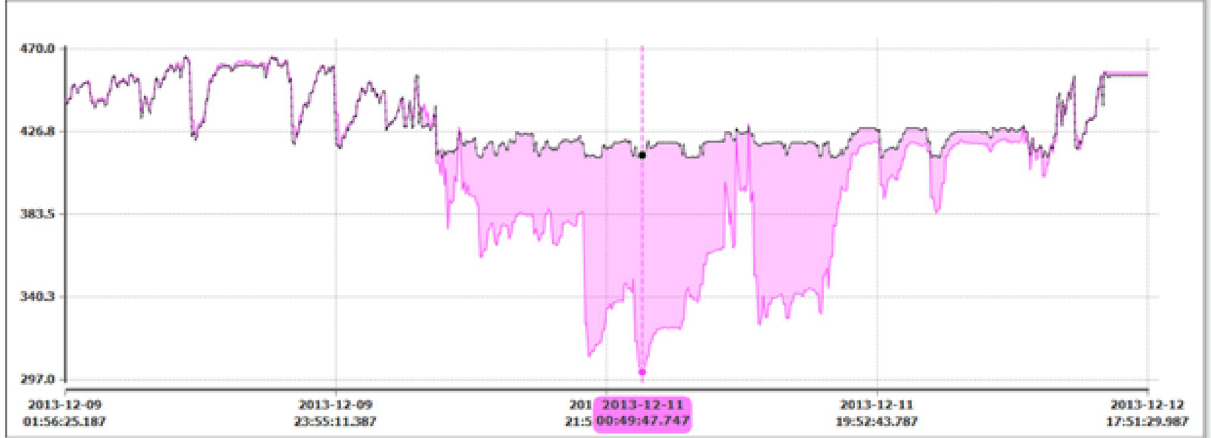
Figure 15. Case 1. Drop in steam temperature. Comparison of the actual and expected trends.